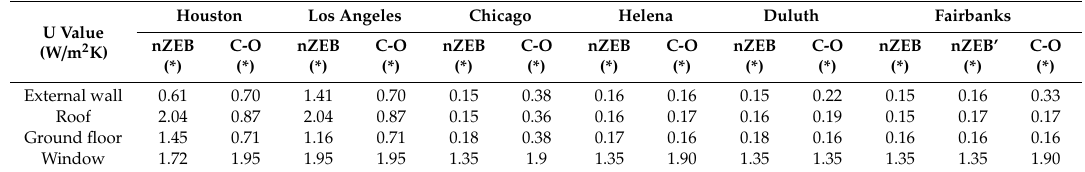
Table 13. Optimal U value of building envelope.